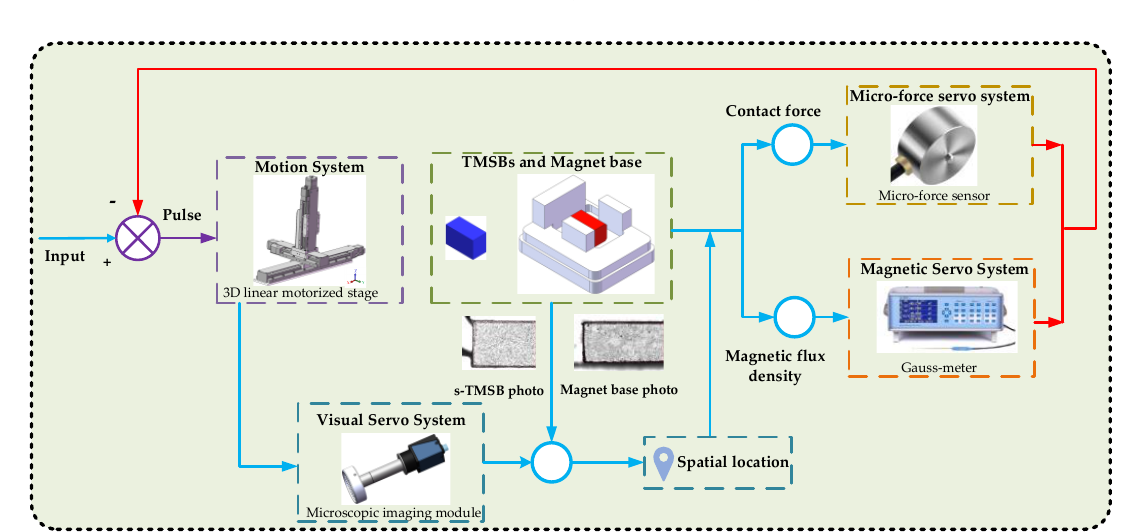
Figure 6. Control strategy for tiny magnetic steel block (TMSB) positioning task.